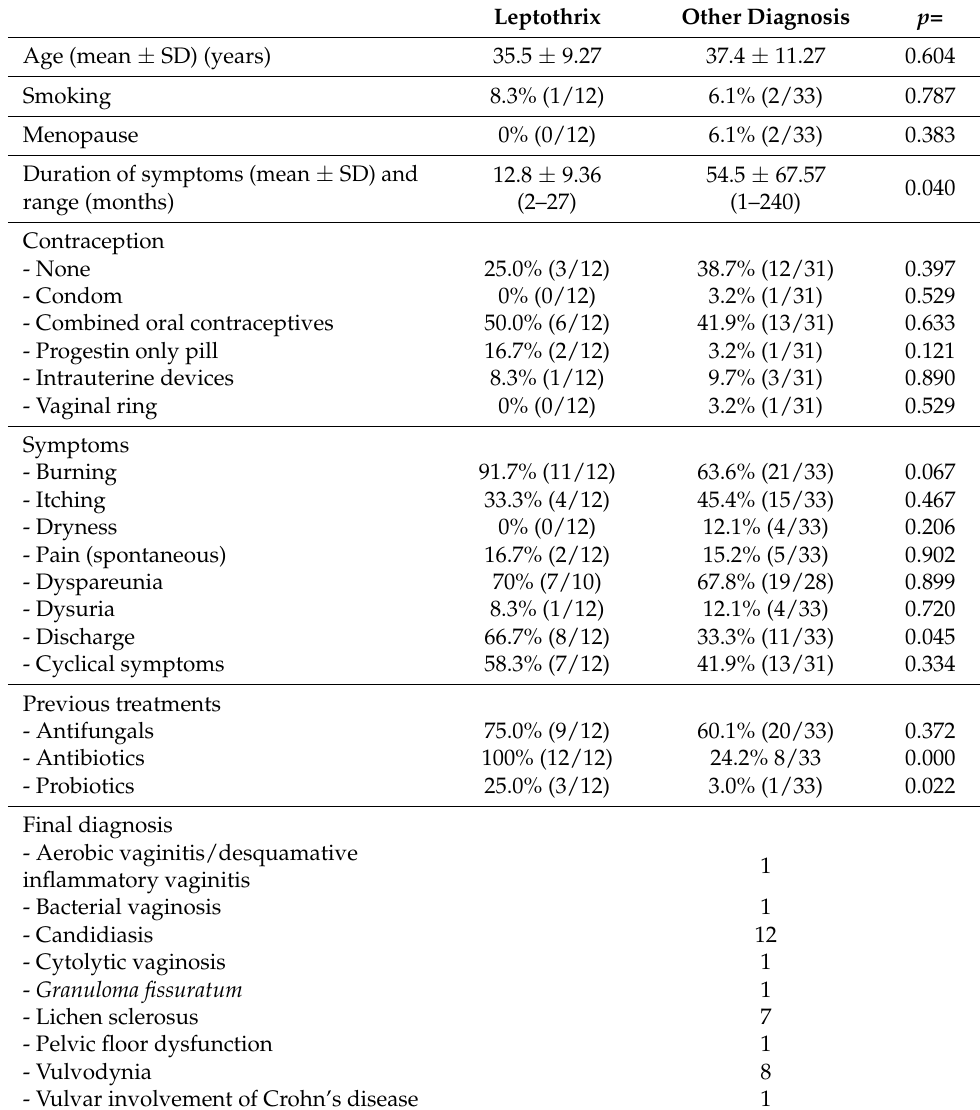
Table 1. Characteristics of women referred for an appointment due to vulvovaginitis and in which leptothrix was found. Women were divided into 2 groups according to whether leptothrix was considered as the final sole diagnosis or if another diagnosis could explain the